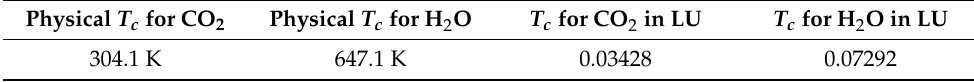
Table 2. Critical temperature of CO 2 and H 2 O in physical and LU units